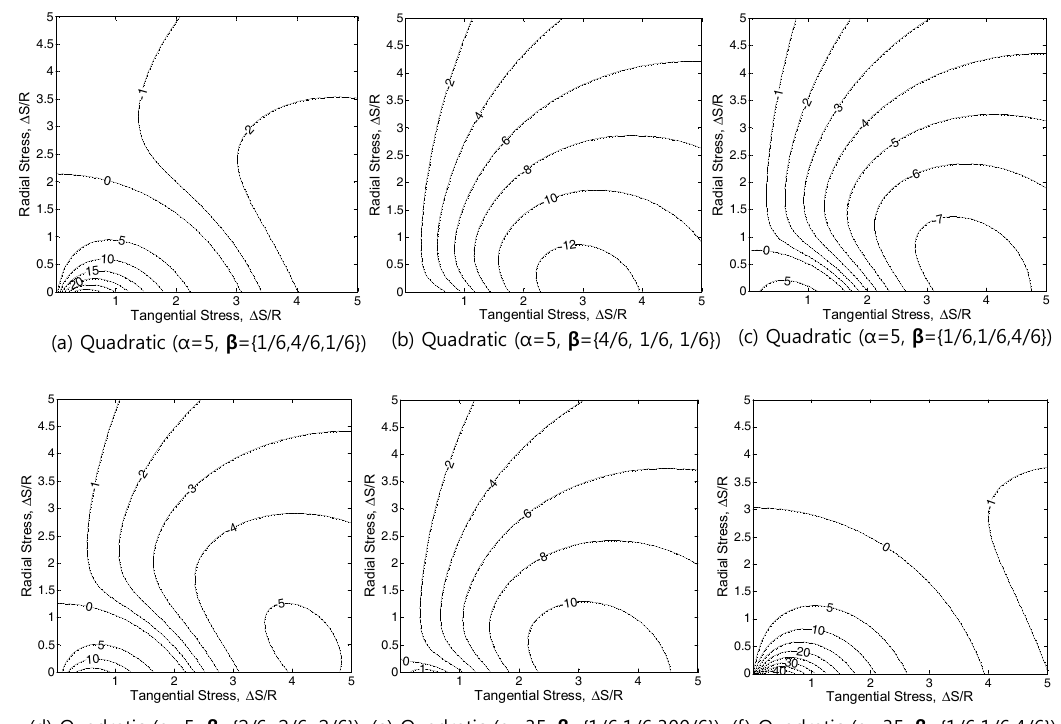
Figure 8. Validation for quadratic α -method: midpoint and backward Euler integration. Metals 2018 , 8 , 66